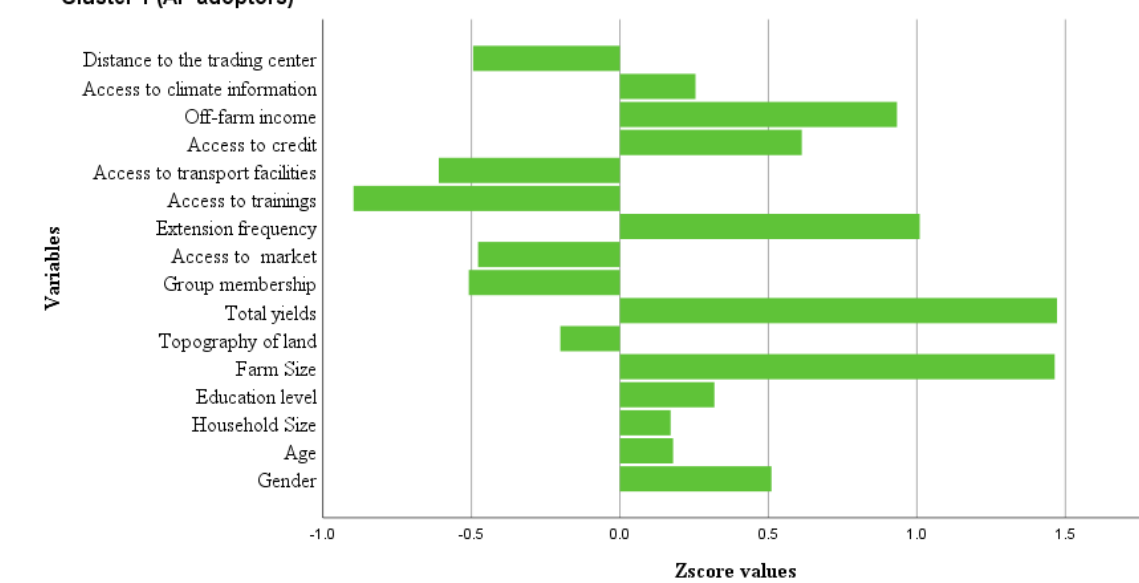
Figure 3. The variables’ distance from the agroforestry (AF) adopters’ cluster center.